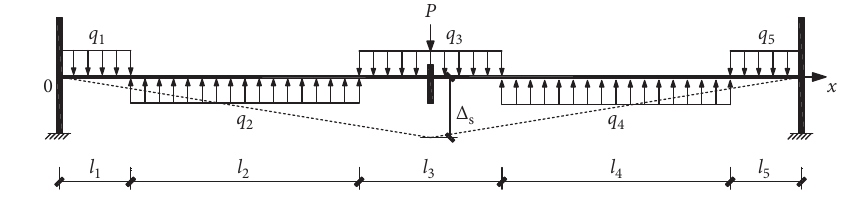
Figure 11: Equivalent uniform loads of the initial prestress.